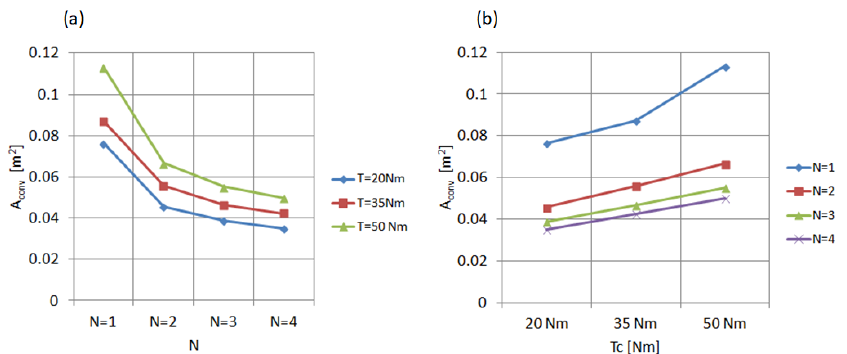
Figure 13. Heat convection areas: ( a ) areas A conv vs. number of discs N for T c = 20, 35 and 50 Nm; ( b ) areas A conv vs. clutching torque T c for the number of discs N = 1, 2, 3, 4.